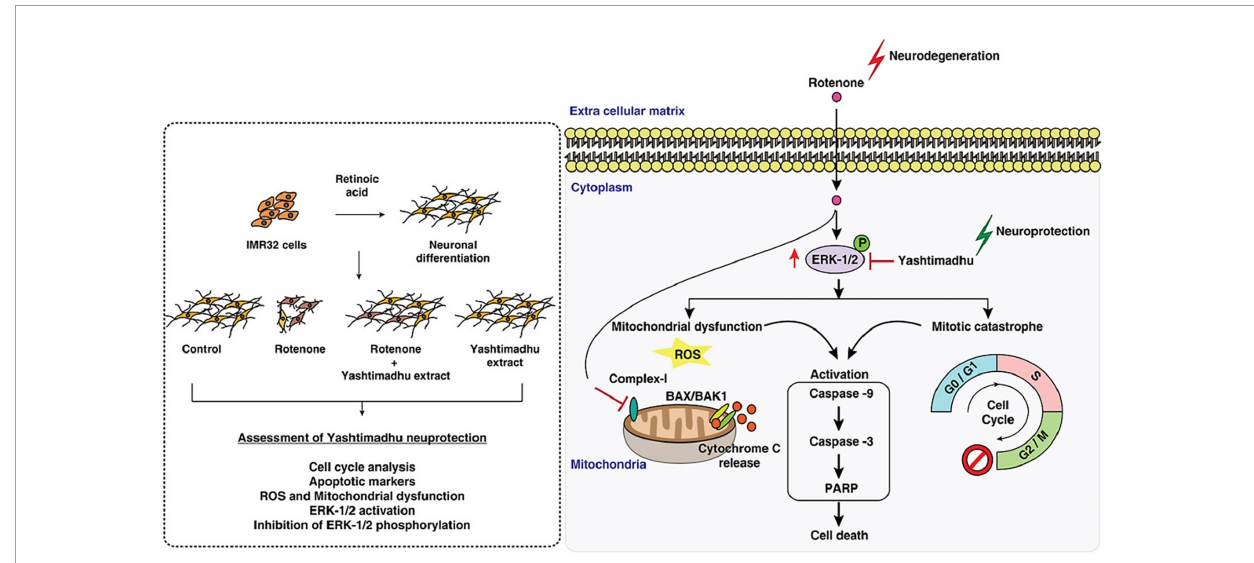
FIGURE3 Mechanism of licorice’s neuroprotective action against rotenone-induced toxicity. Reproduction authorized. Elsevier l’ 2021 Elsevier B.V. (Karthikkeyan et al.,